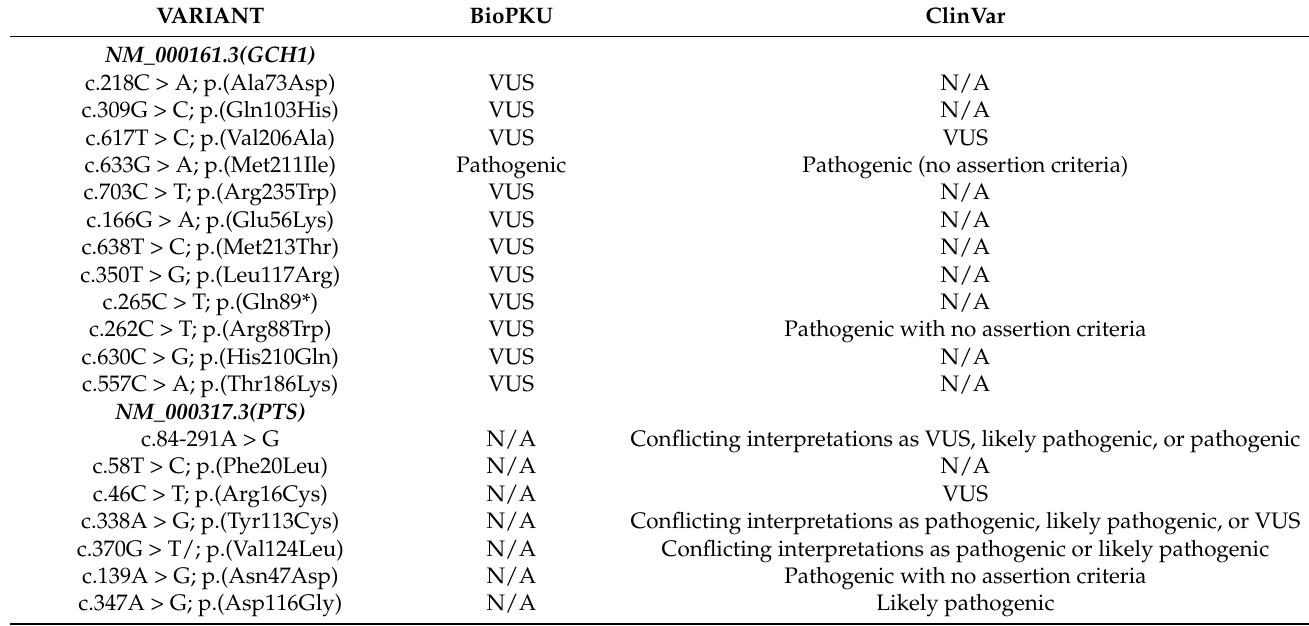
Table 2. Interpretation of variants with the most significant clinical implications, as discussed in